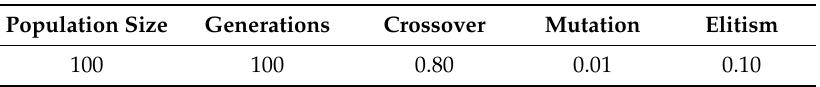
Table 1. Parameters used for the HGA based on typical values found in